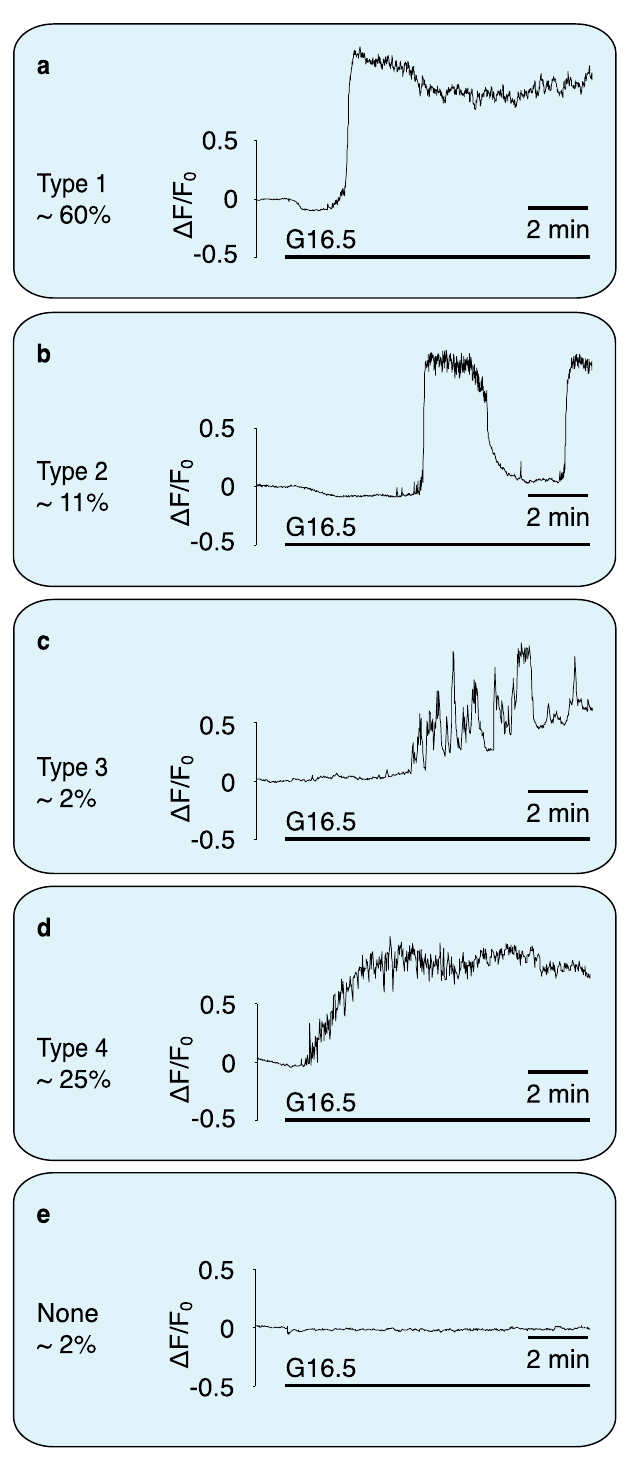
Figure 1. Classification of β-cell sub-membrane Ca 2+ responses to elevation in glucose as recorded with TIRF. Responses to 16.5 mM glucose at 37° C in mouse primary pancreatic β-cells. n = 239. Responses from 1,017 cells were analysed overall. Percentages are of 239 control cells of male WT mice of one genetic background to exclude potential genetic- or sex differences in response type distribution. Approximately 96% showed a prominent global calcium response. In 116 cells, 16.5 mM glucose evoked a mean peak height of 2.4 ± 0.01 ΔF/ F 0 . ( a ) The most common response (type 1, ca. 60% of responses) resembles the standardized triphasic response. ( b ) The slow Ca 2+ oscillations classified as type 2 often occurred at periods of ca. 5 min. ( c ) Response type 3 consists of numbers of large transients superimposed on a slow increase in Ca 2+ . These responses were rare (ca. 2%). ( d ) Type 4 responses (ca. 25%) resemble the triphasic response, but with a less steep Ca 2+ rise. ( e ) A very small number of cells did not respond to glucose (ca.